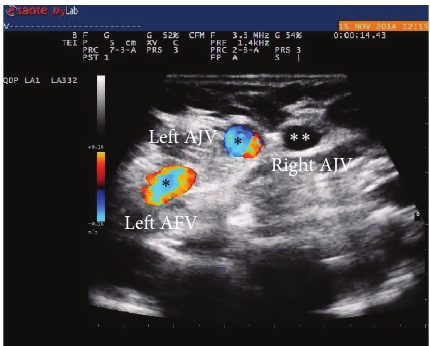
Figure 3: Normally evoked blocked flow ( ∗∗ ) in the right anterior jugular vein (AJV) with abnormal reflux ( ∗ ) in the anterior jugular (AJV) and facial veins (AFV) of the left side ( ∗ ).